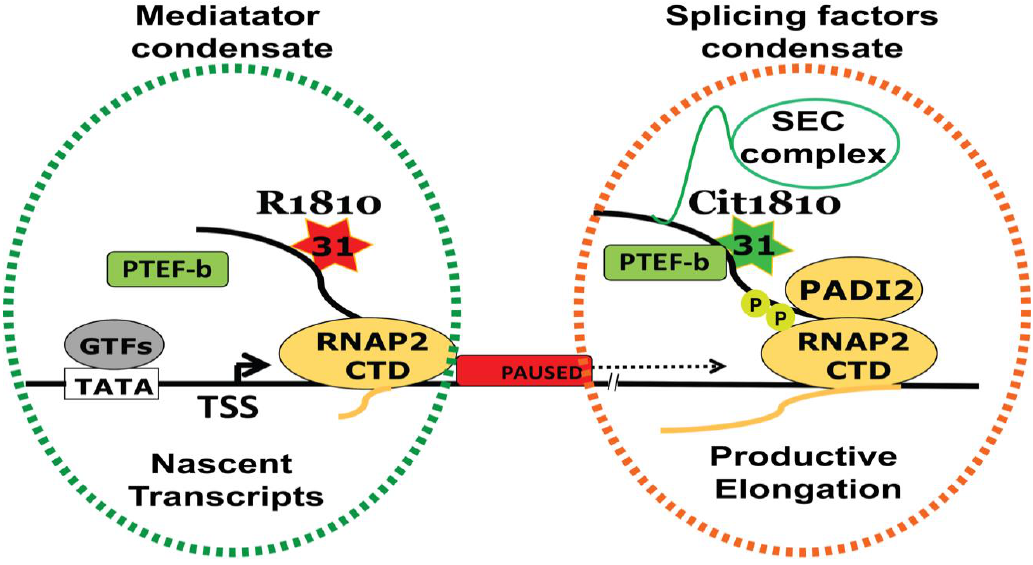
Figure 3. PADI2-mediated cit1810 RNAP2 is a new player in transcription regulation. PADI2 catalyzed R1810 to Cit1810 at RNAP2-CTD facilitates the association with the P-TEFb complex (comprises CDK9-CCNT1). This interaction overcomes RNAP2 pausing and increases in transcription and cell proliferation. An increased association between the P-TEFb complex and RNAP2-CTD most likely attracts associated complexes including Super Elongating Complex (SEC) to facilitate active RNAP2 encompassing splicing factor condensate (orange dotted) derive transcription regulation. However, R1810 along with nascent transcripts forming mediator complexes condensate (green dotted). TSS = transcription start site; GTFs = general transcription factors.